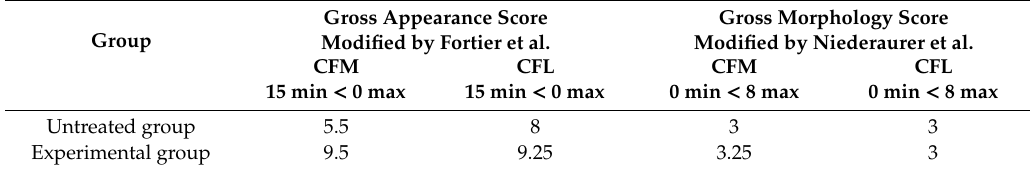
Table 1. Macroscopic scores at six months for untreated and experimental groups. Gross Appearance Score Group Modified by Fortier et al.